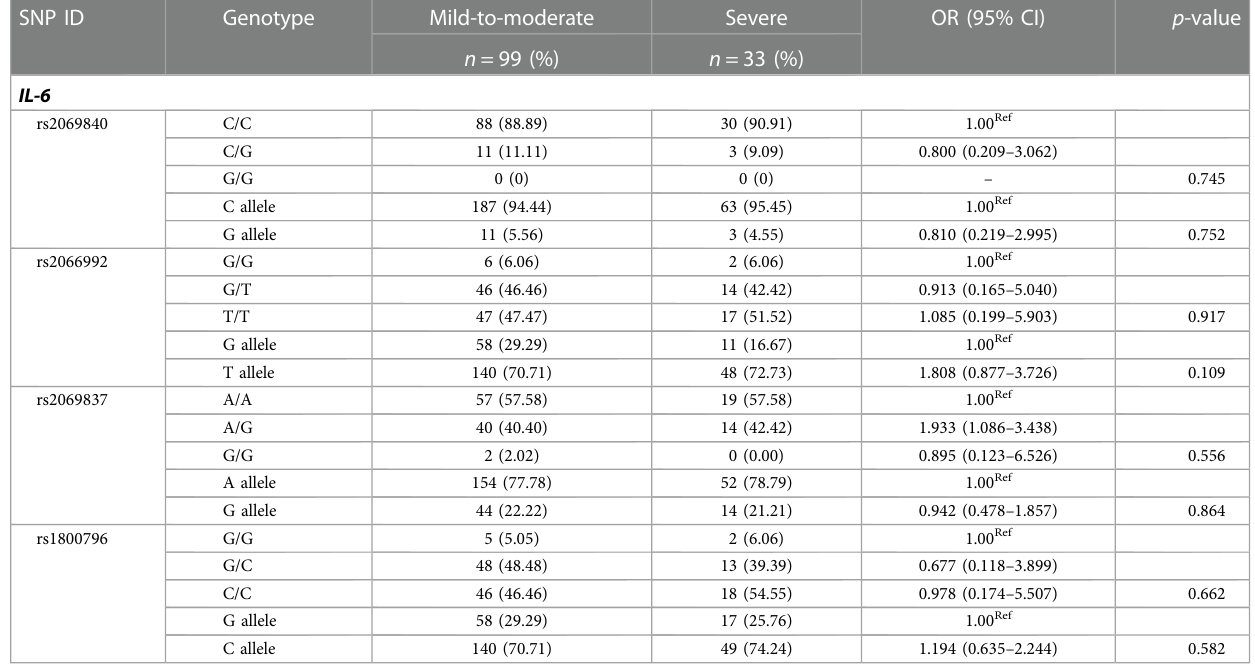
TABLE 7 Genotype and allele frequencies of IL-6 SNPs in patients with mild-to-moderate and severe AD. SNP ID Genotype